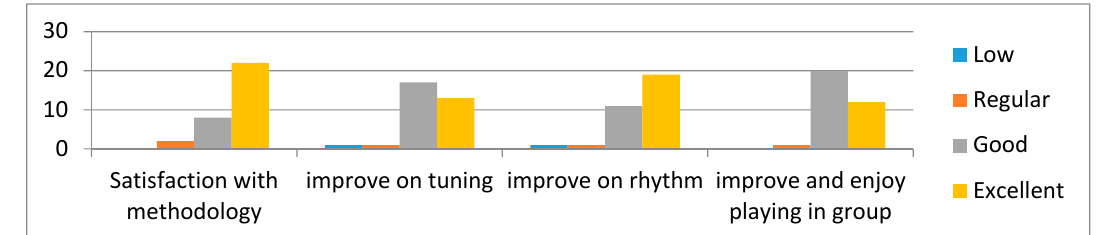
Figure 6. Satisfaction and improve of music skills with